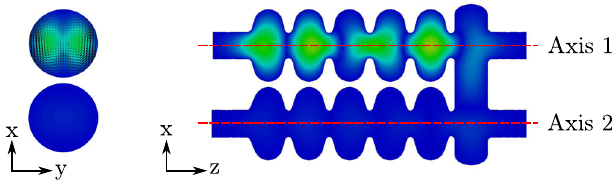
FIG. 10. A transverse and longitudinal slice showing the electric field contour plots for a mode at 1.73 GHz. The transverse slice also shows the magnetic field as indicated by the cones.